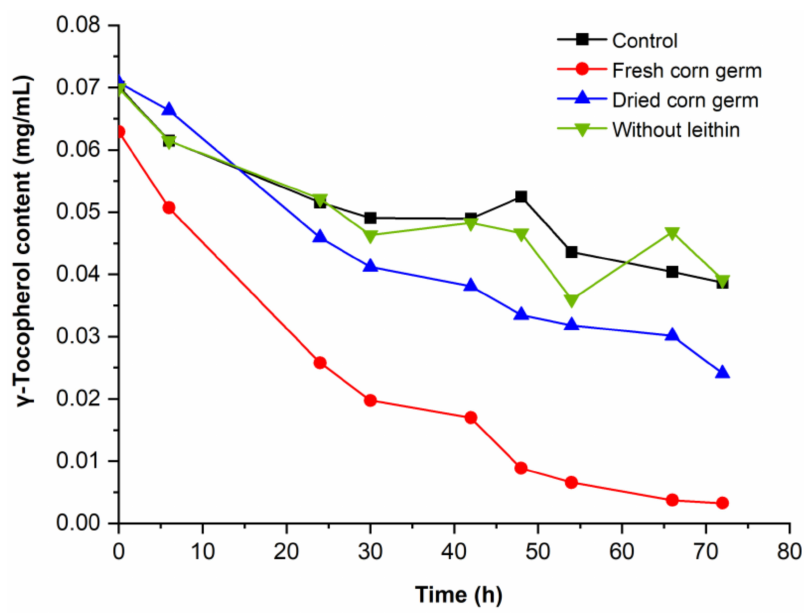
Figure 1. Residual γ -tocopherol content during the reaction (0–72 h).